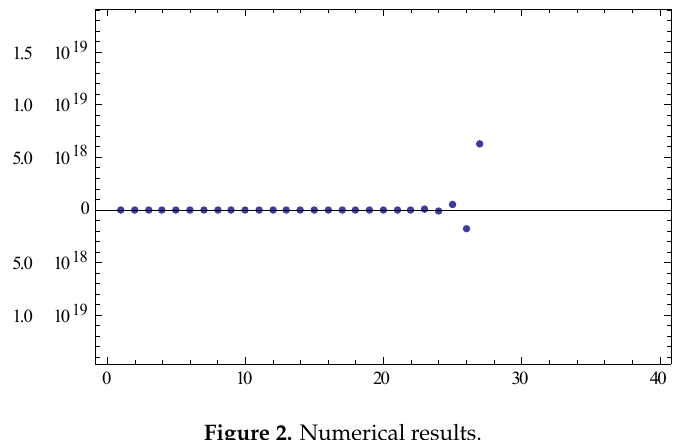
Figure 2. Numerical results.